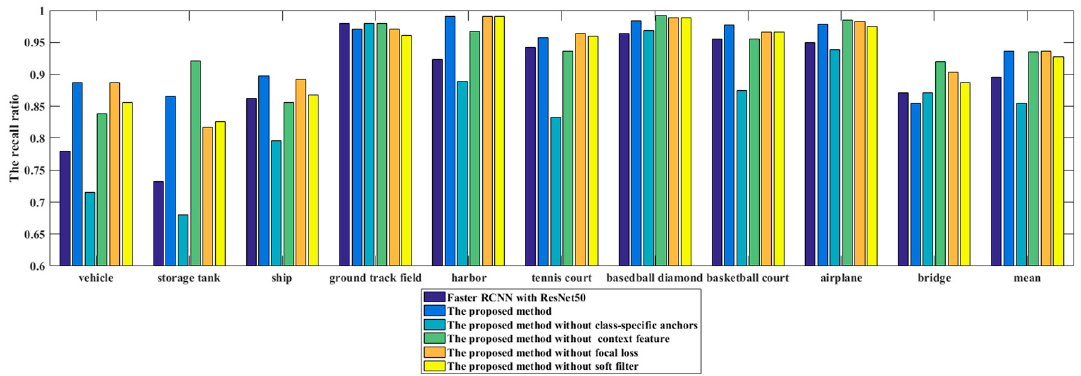
Figure 13. The recall ratio of ablation studies for each class in the NWPU VHR-10 dataset.